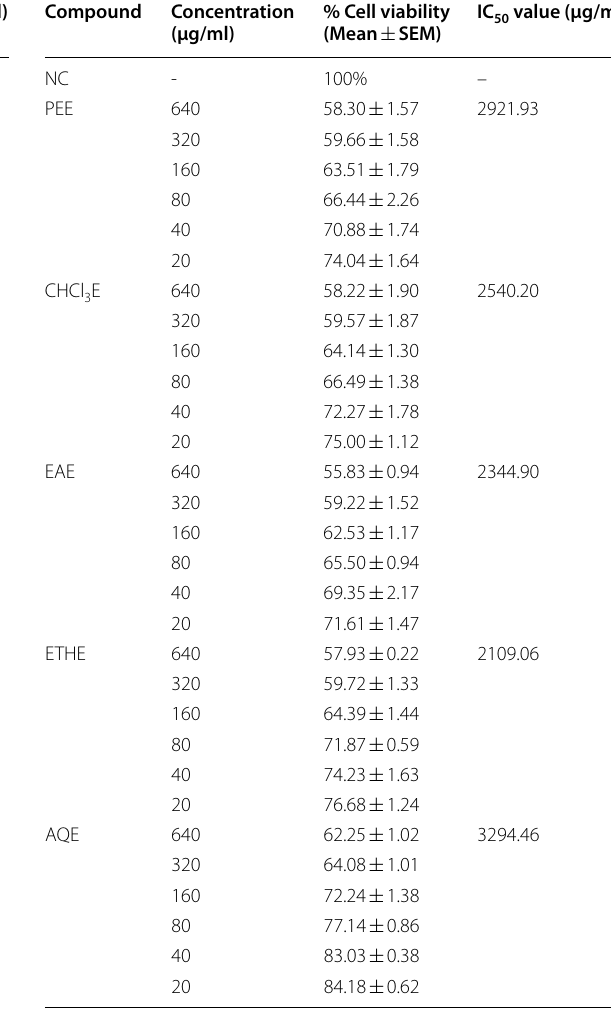
Table 2 Effects of different leaf extracts of Convolvulus pluricaulis on Normal Cell